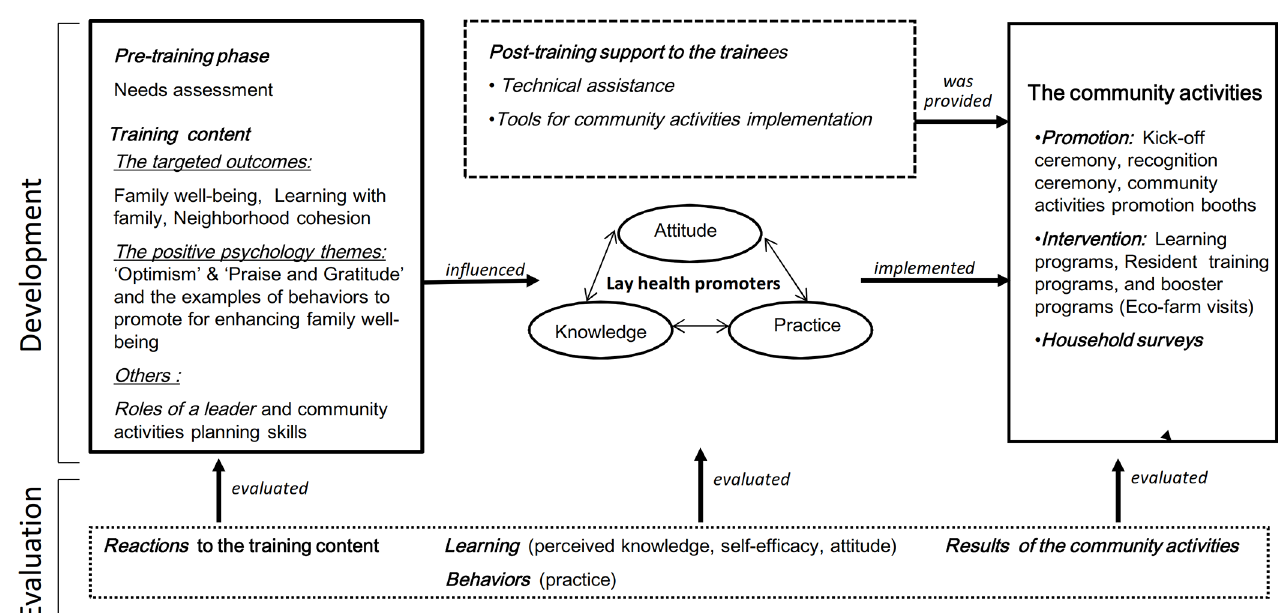
Fig 1. The framework for the development and evaluation of the train-the-trainer workshop to implement community intervention program.